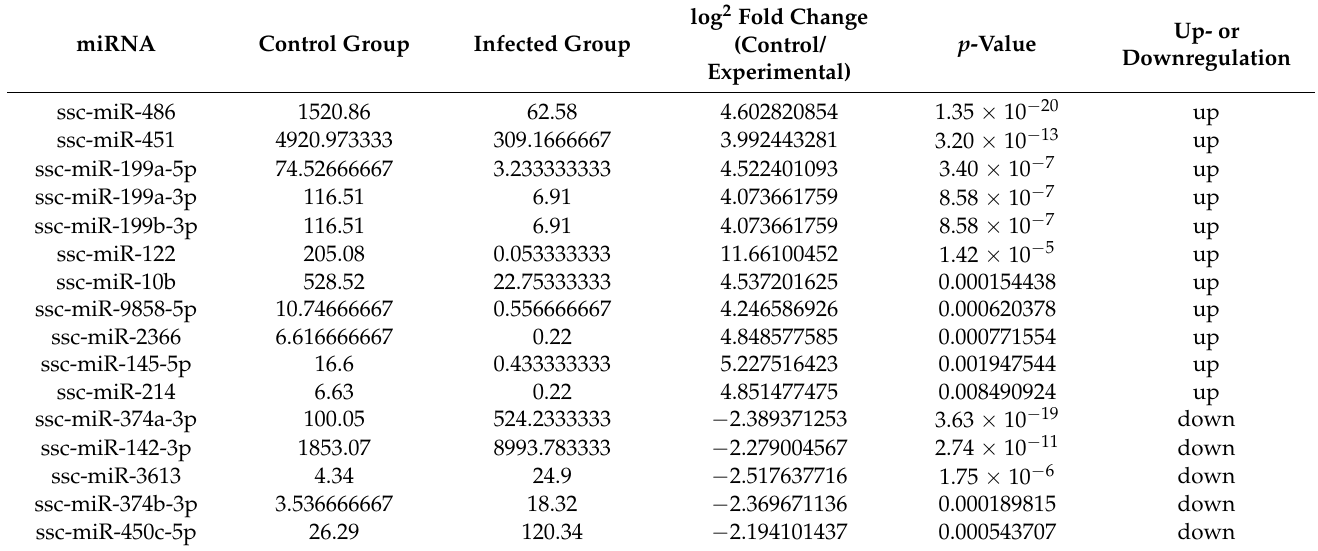
Table 3. Differentially expressed